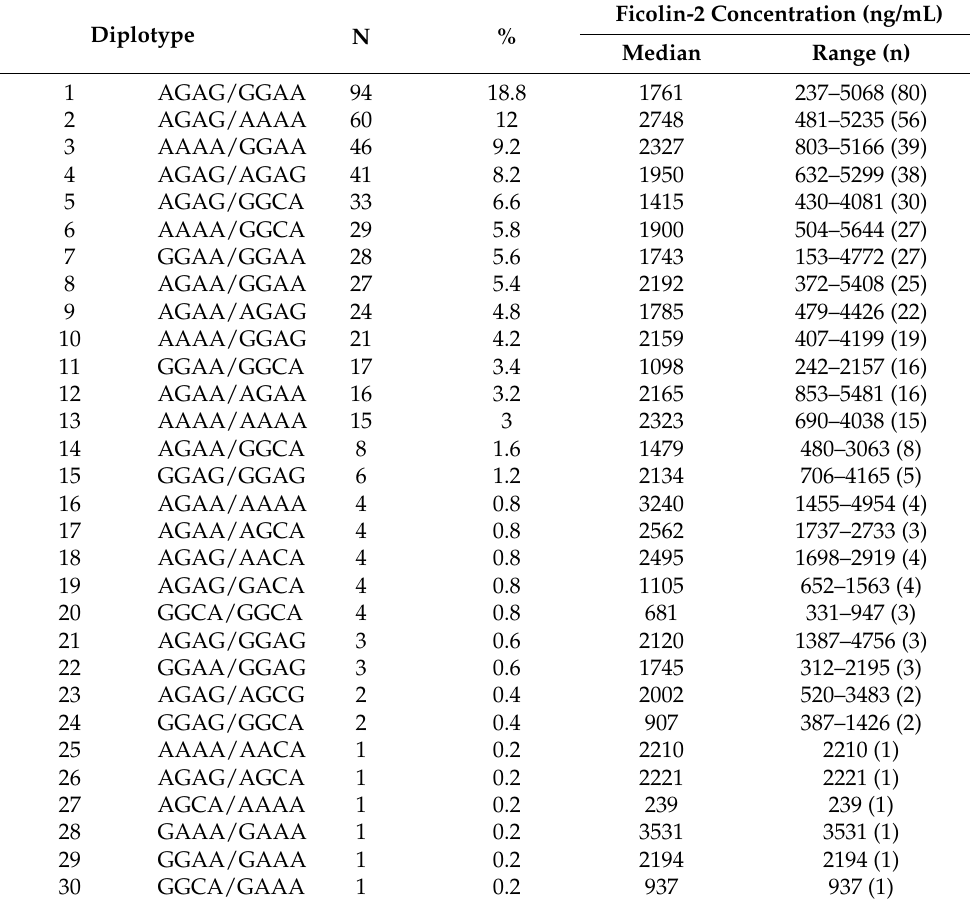
Table 5. Frequencies of diplotypes identified in preterm newborns (n = 501).